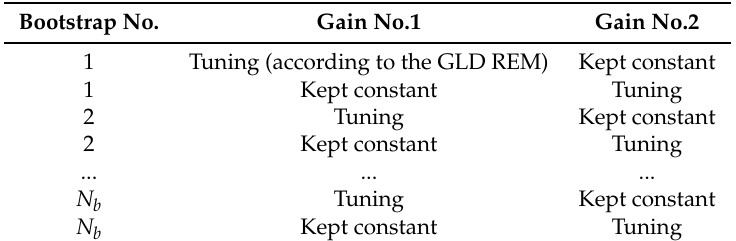
Table 2. Steps in the bootstrapping mechanism.